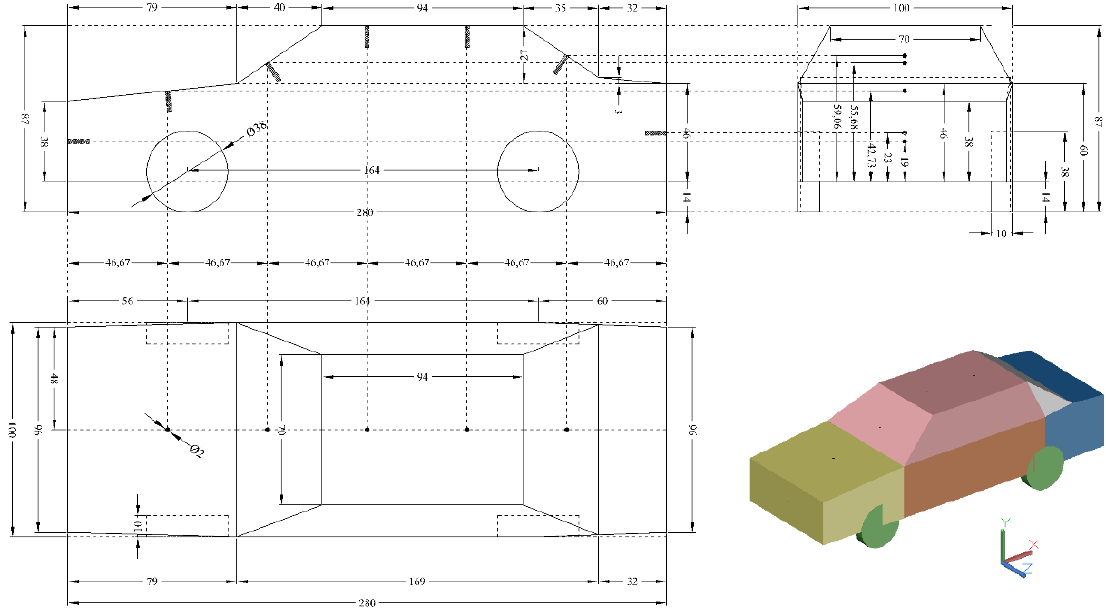
Figure 1. External dimensions of the test model and the pressure measuring points (unit, mm).